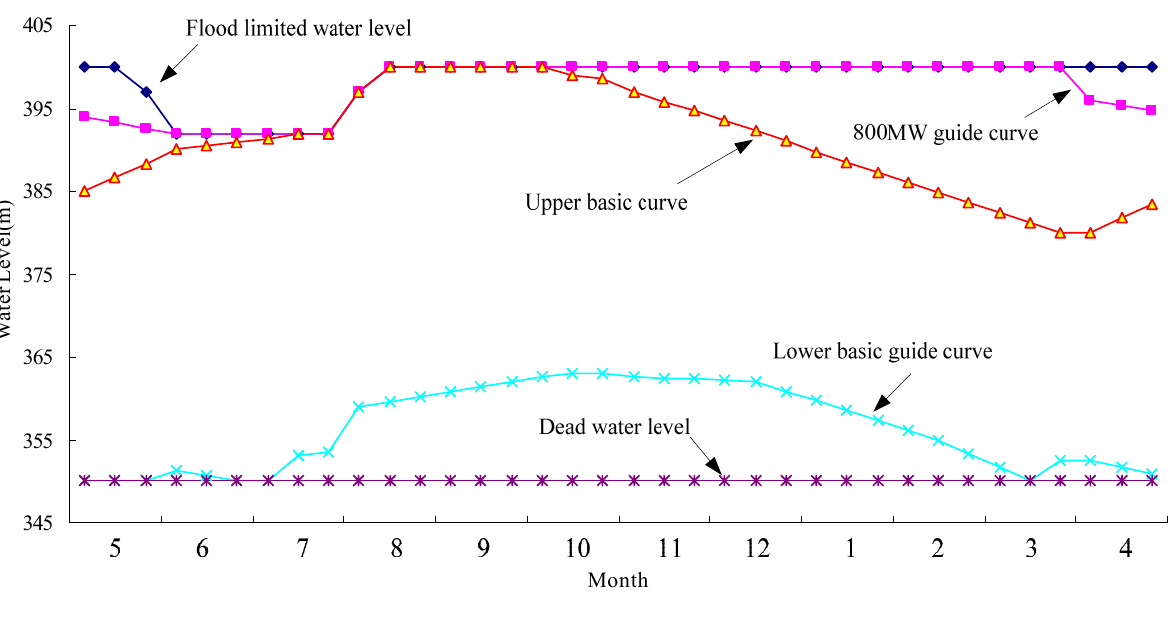
Figure 4. Designed operating rule curves of the Shuibuya